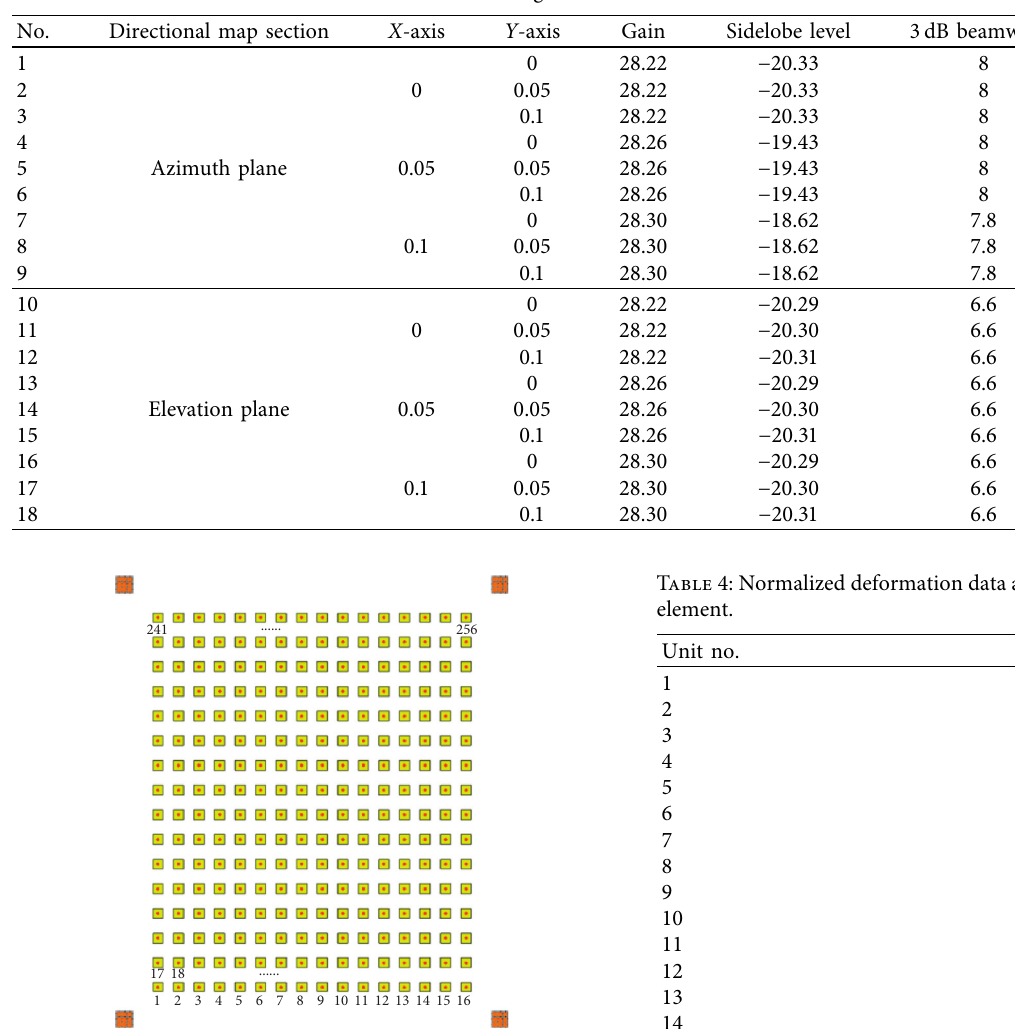
Table 3: XY -direction changes at the same time technical indicator